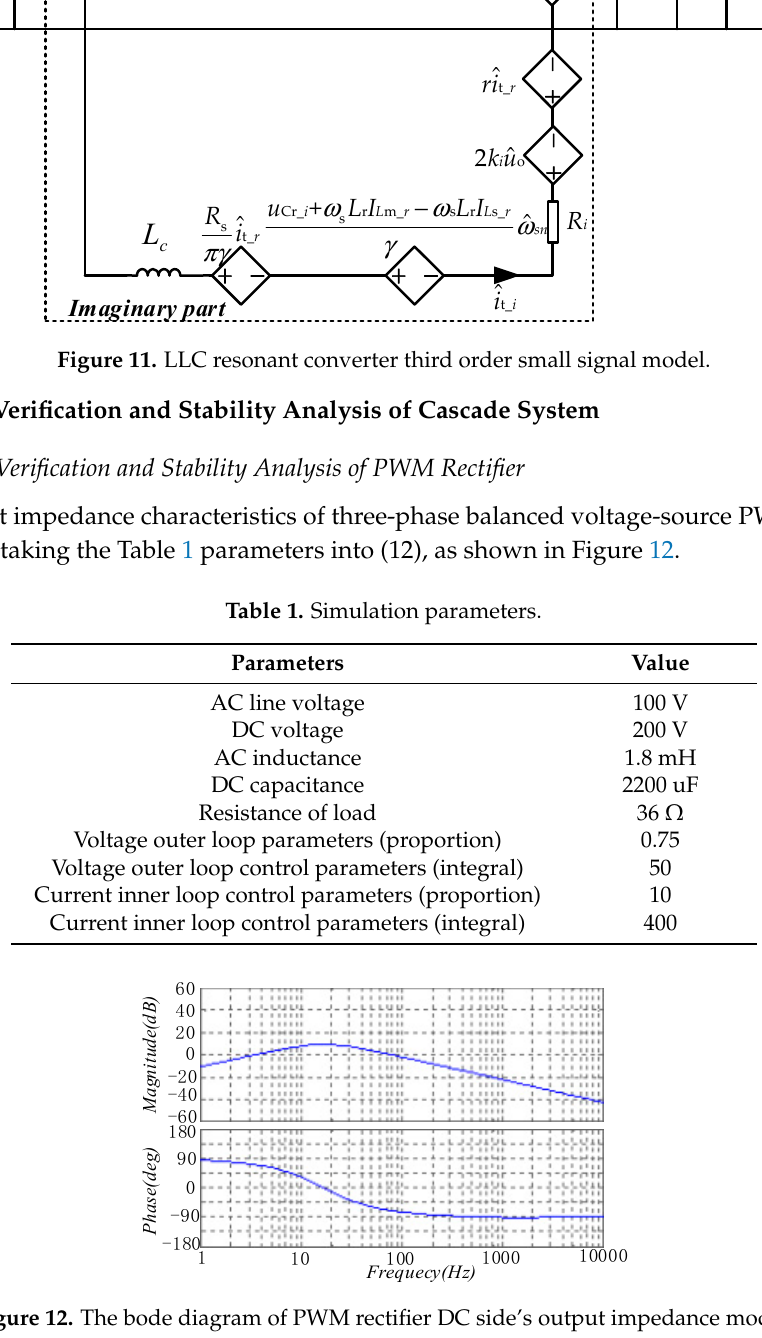
( c ) Figure 13. Simulation diagram of three-phase balanced PWM rectifier. ( a ) Steady waveform of Three-phase voltage; ( b ) Steady waveform of Three-phase current; ( c ) DC dynamic capacitance voltage waveform.